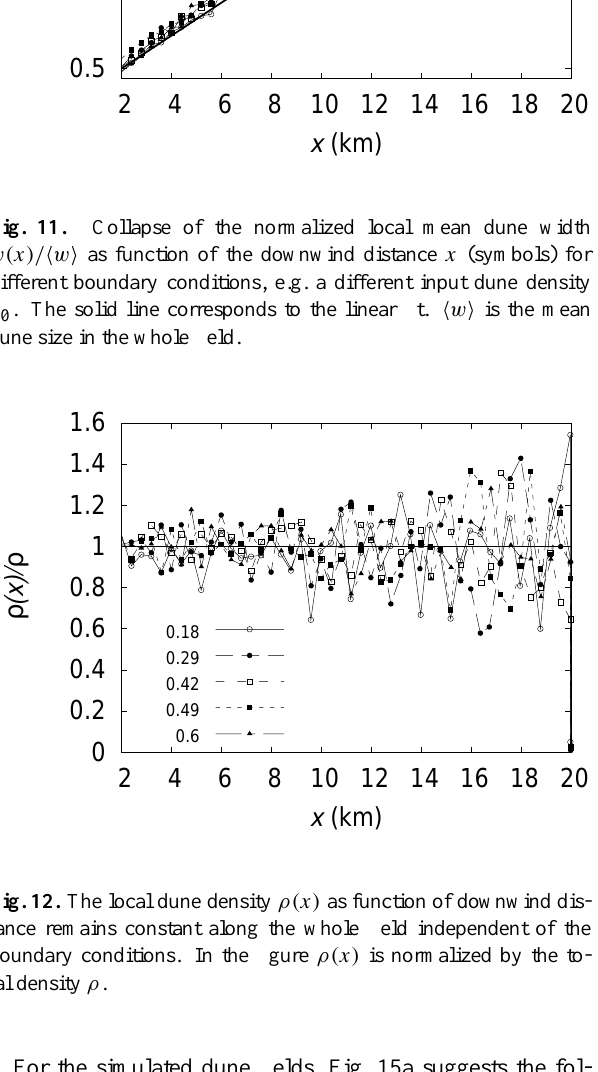
Fig. 14. Dune density ρ as a function of the relative inter-dune spacing h L i / h w i for the real dune fields in Fig. 1 ( ◦ ), simulated dune fields ( • ) and the fit (solid lines) when both are taken into